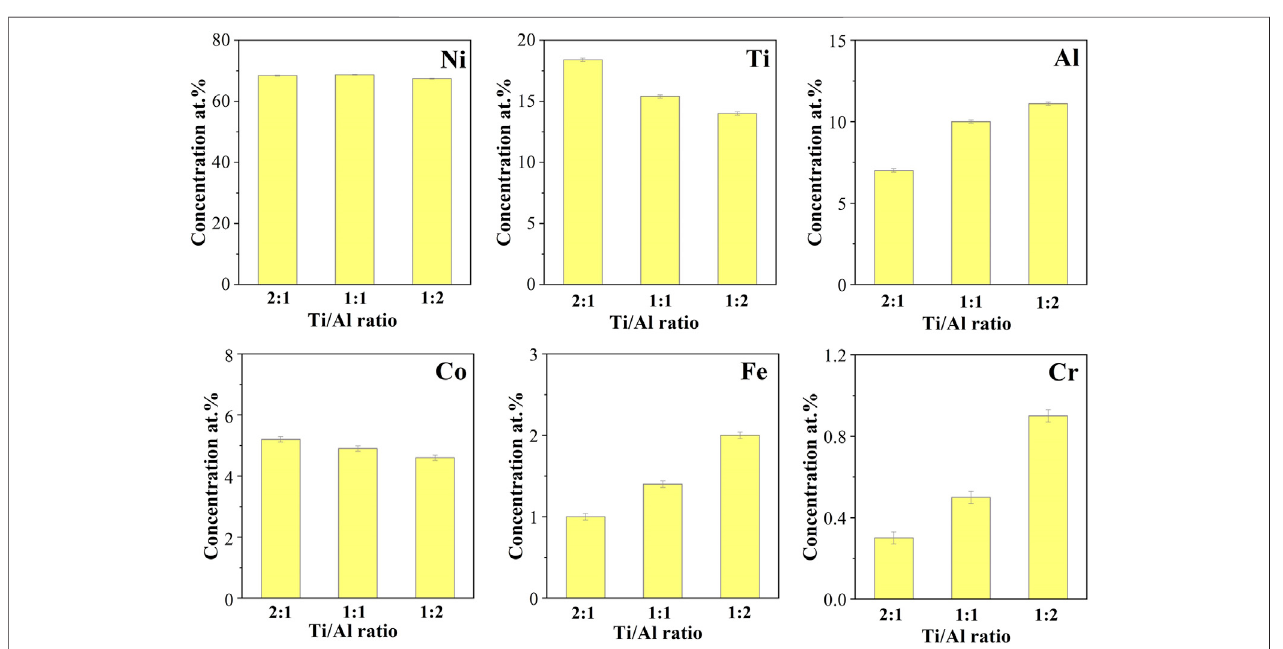
FIGURE 3 | The concentration of each elements in the γ ′ nanoparticles as a function of Ti/Al ratio.